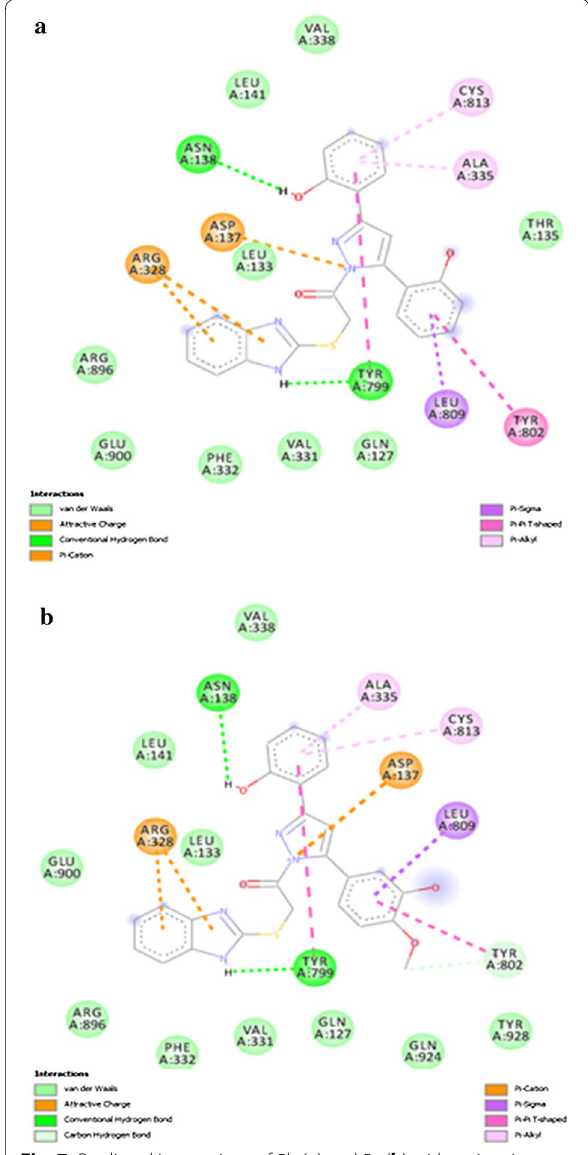
Fig. 7 Predicted interactions of 5b ( a ) and 5c ( b ) with active